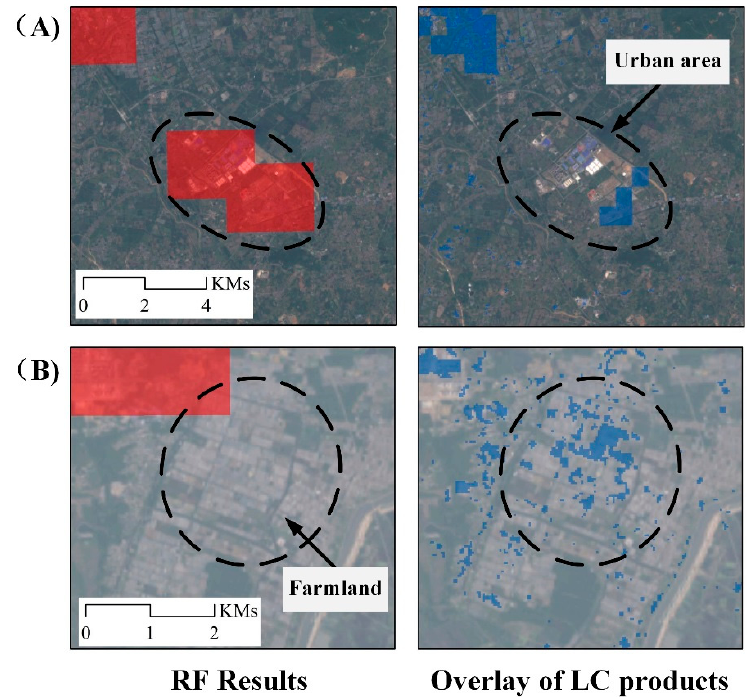
Figure 11. A comparison between the RF results and the overlay of three land cover (LC) products (2017 MODIS / LC, 2015 GHSL30, and 2015 HMMGUL). The row ( A ) shows that the RF classifier detects the urban area while the LC products cannot. The row ( B ) shows that the LC products classify farmland as an urban area while the RF classifier does not.